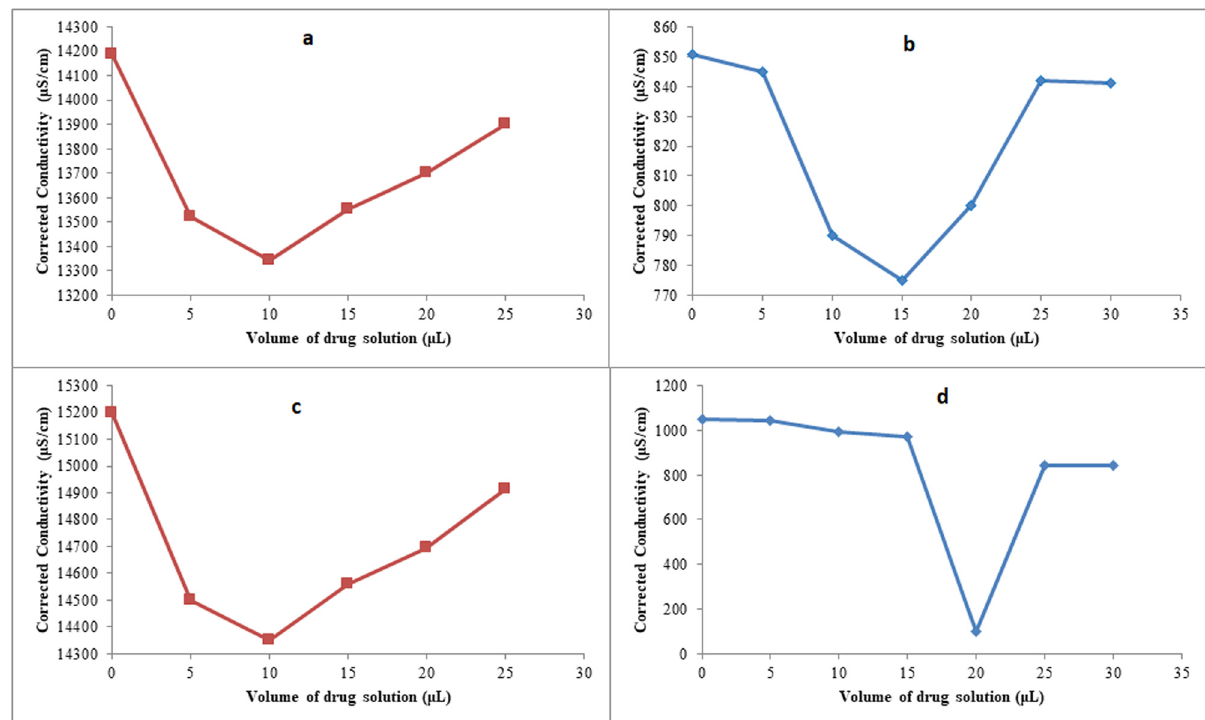
Figure 2: Conductometric titration curve showing corrected conductance values against the volume of imatinib ( a ) , sorafenib ( b ) , ge fi tinib ( c ) and bosutinib ( d ) solutions added in Cu 2 + solution ( 10 mL ) in the titration